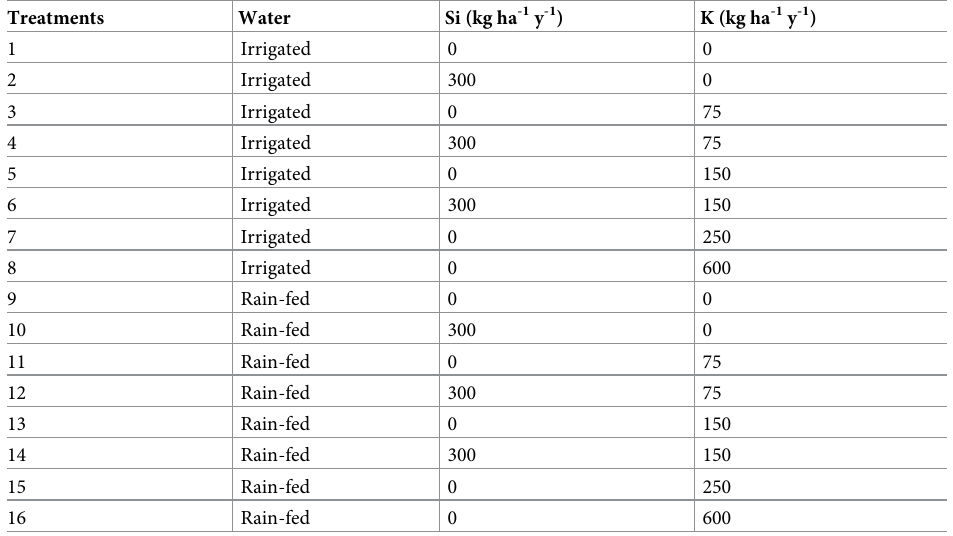
Table 3. Treatments applied in the potassium response